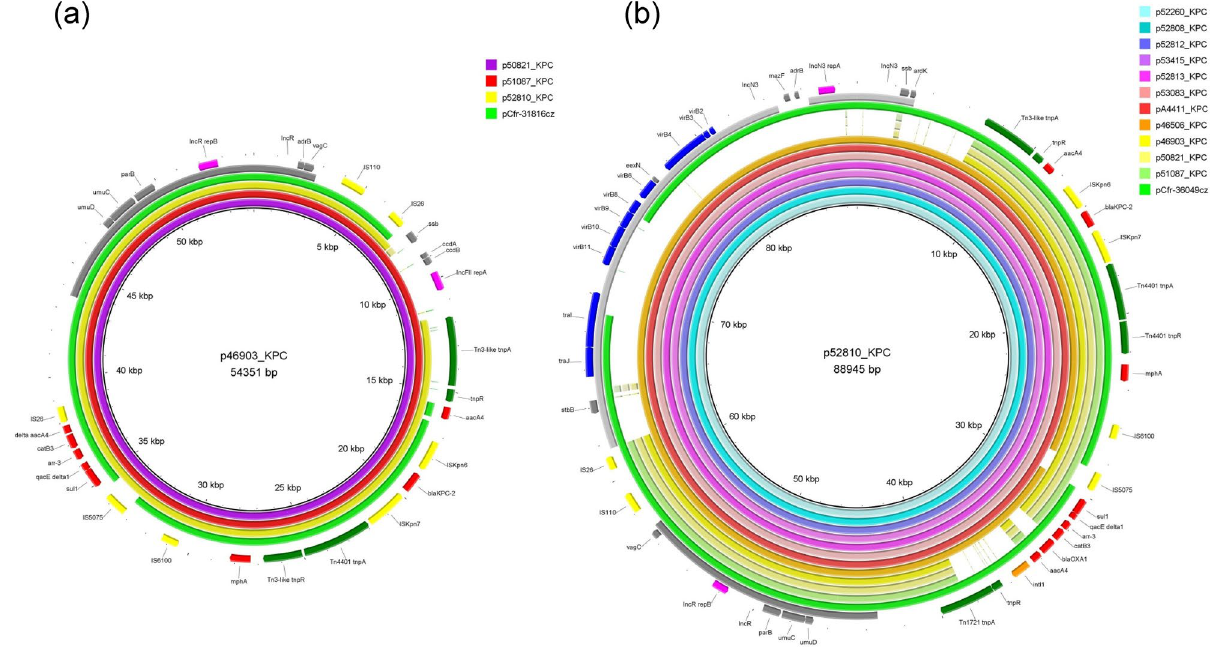
Figure 1. BRIG comparison of IncR KPC-encoding plasmids characterized from Enterobacterales isolates recovered from Czech hospitals.